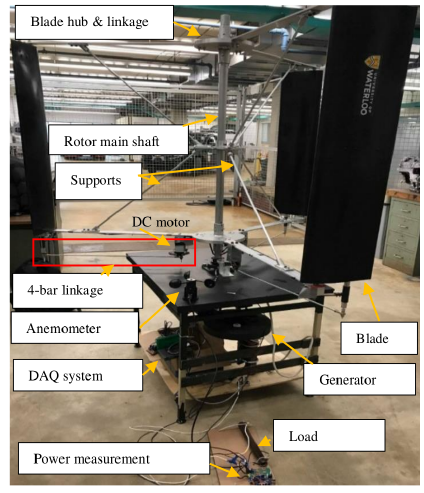
Figure 6. Final assembly of the H-type